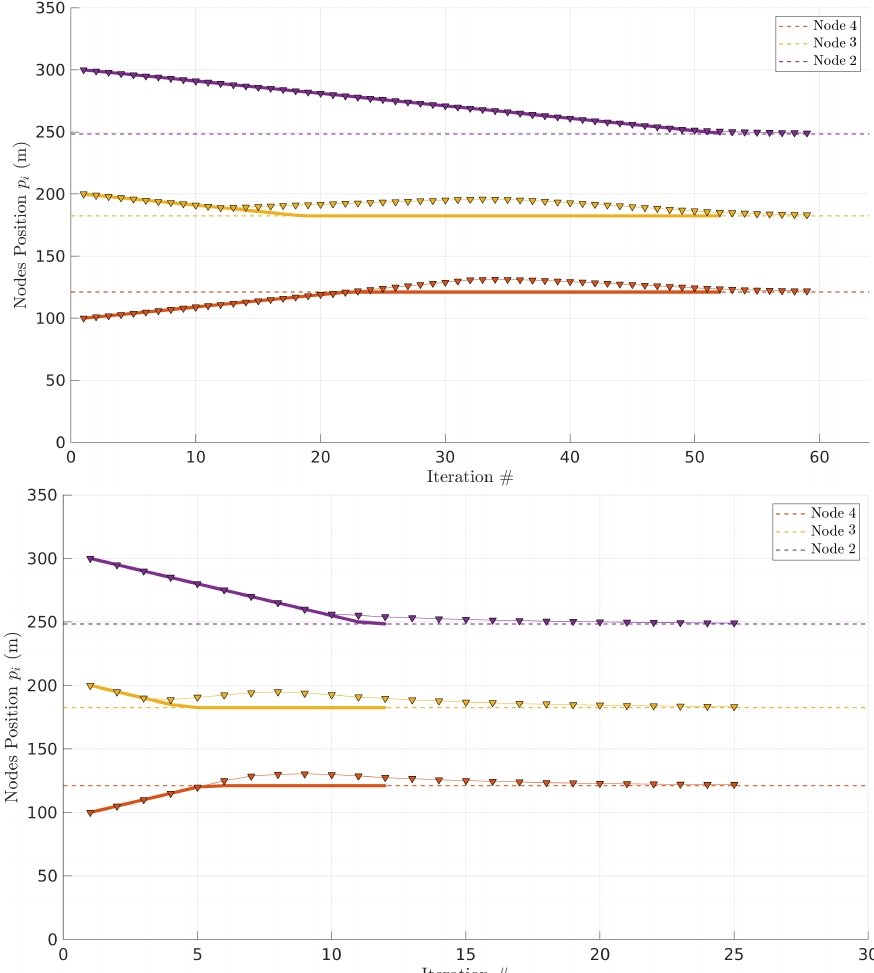
Figure 13. Nodes converging to their optimal position. Triangles represent relay positions every step of the distributed approach. Solid lines show the evolution of a centralized approach. Iterations with T = 1 s ( top ) and T = 5 s ( bottom ); note the different horizontal scales. The dashed lines represent the optimal positions for all the relays. The solid